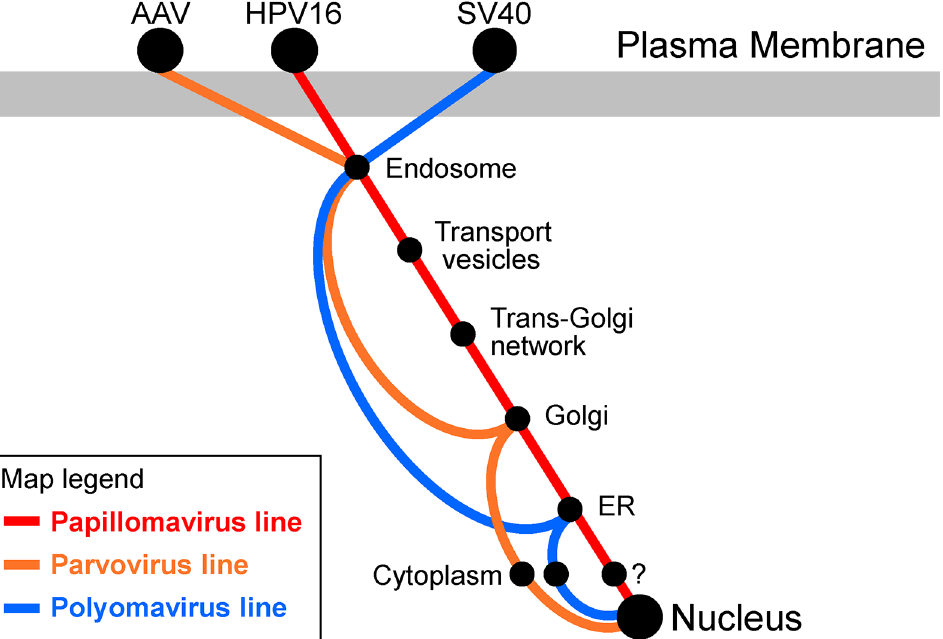
Fig 1. Transit pathways used by small DNA viruses. The map shows our current understanding of the intracellular trafficking pathways used during entry by three families of small DNA viruses: human papillomaviruses (red), parvoviruses (orange), and polyomaviruses (blue). A prototype member of each virus family is shown at the top, where it binds to a distinct receptor at the cell surface. Receptors and vesicular sites implicated in virus entry are represented by the black spots. Parvoviruses and polyomaviruses are thought to exit the vesicular pathway into the cytoplasm prior to nuclear entry. HPV engages the retromer to exit the endosome, but it is unclear if there is a distinct cytoplasmic